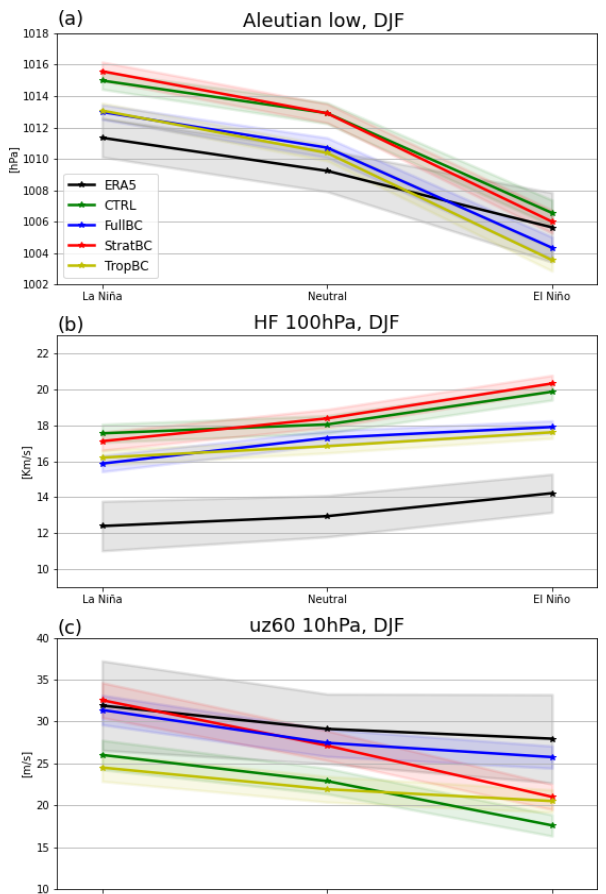
Figure 4. DJF values in the model and ERA5 of (a) Aleutian low index, (b) heat flux between 45–75 ◦ N at 100hPa, and (c) UZ60 for La Niña, neutral, and El Niño years. Shading shows 95% confi- dence